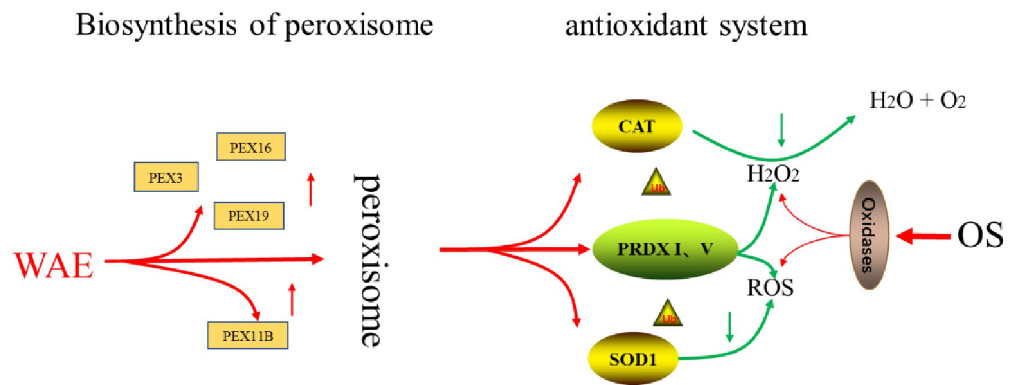
Fig 8. Regulation of WEA on antioxidant mechanism of Tibetan pig